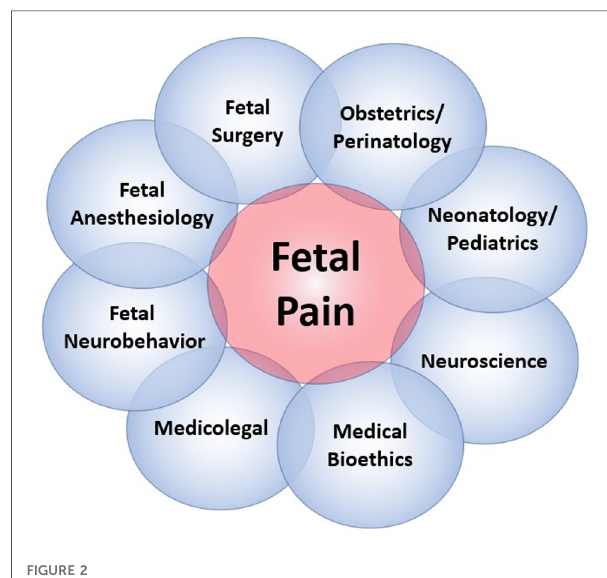
FIGURE 2 The multidisciplinary dimensions of fetal pain research.